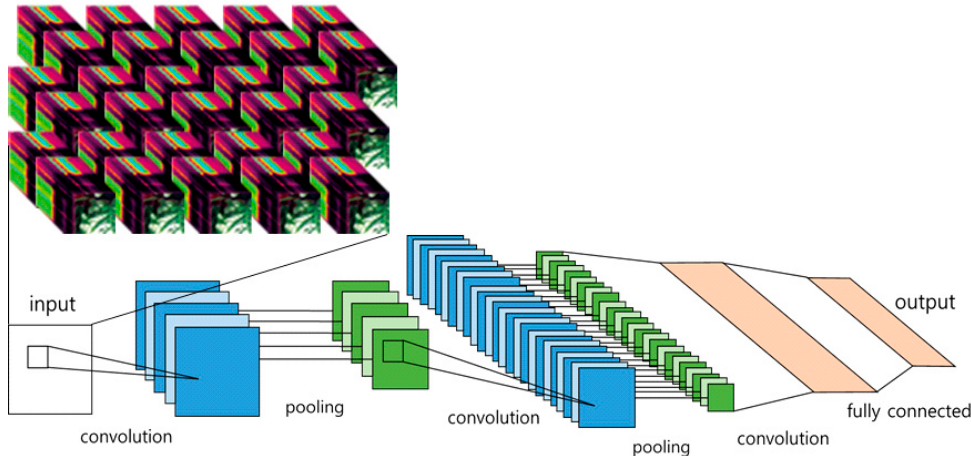
Figure 5. Hyperspectral data and CNN model structure.